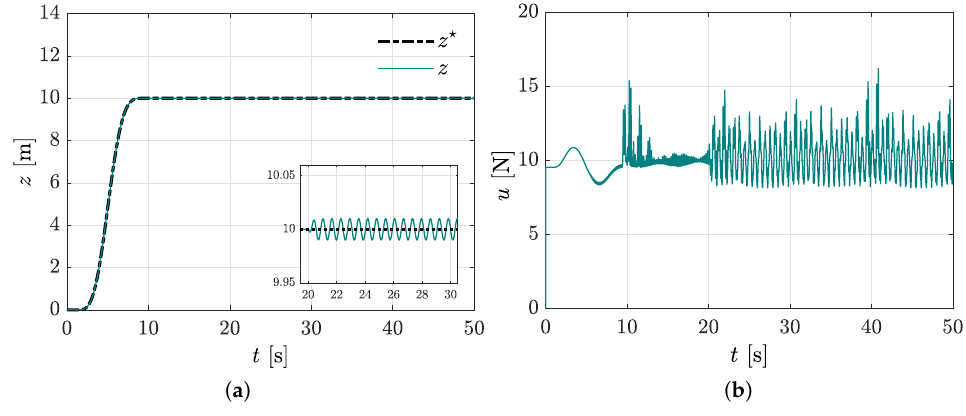
Figure 12. Controlled vertical dynamics, case 2.2. ( a ) Tracking using the vibration absorber with disturbances. ( b ) Main u force control